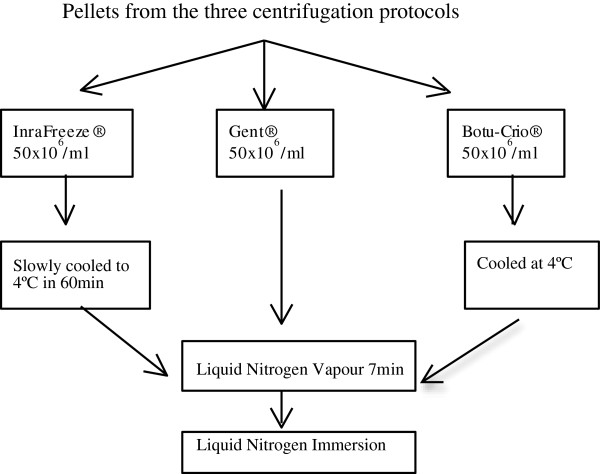
Addition of post-centrifugation pellets to extenders, and cryopreservation.